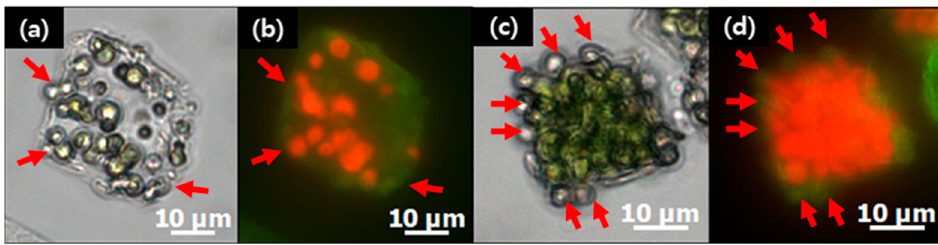
Figure 10. Optical-microscopic images of microalgal cells grown in the CaCO 3 crystal-removed polymer microcapsule for ( a , b ) one day and ( c , d ) three days in the ( a , c ) bright-field and ( b , d ) fluorescent modes.